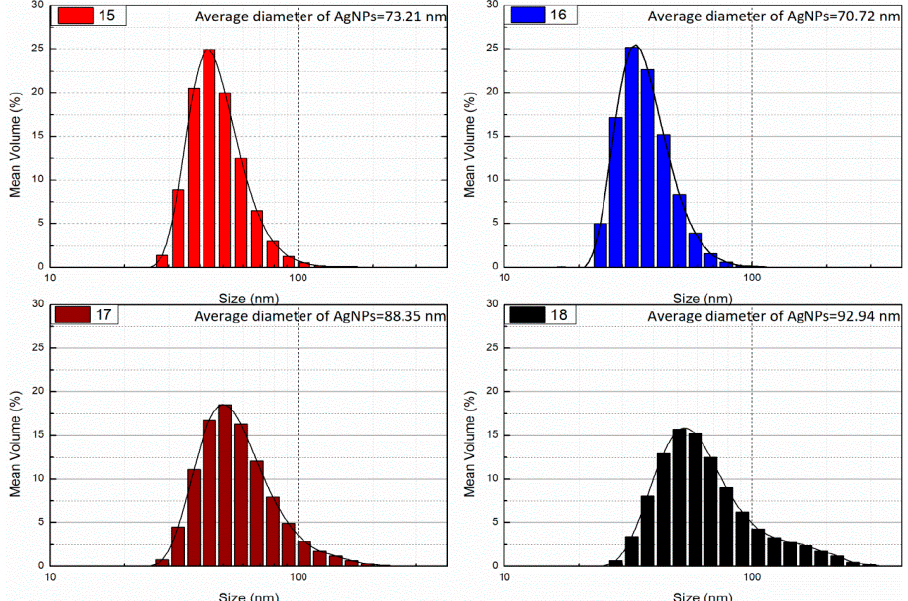
Figure 3. DLS analysis of AgNPs, hydrodynamic diameter of selected